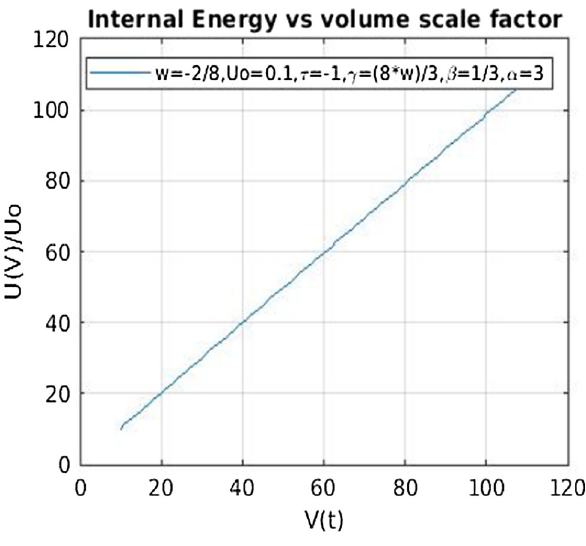
; U = 0 . 1 ; τ = − 1 ; γ = 0 8